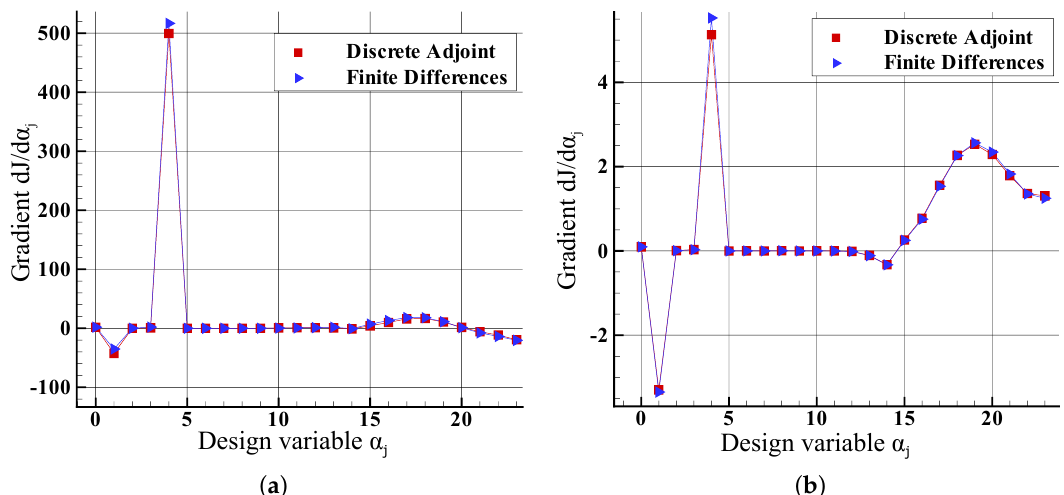
Figure 3. Objective gradients compared to finite differences. ( a ) Entropy generation ( J 1 ); ( b ) Exit flow angle ( J 3 ).